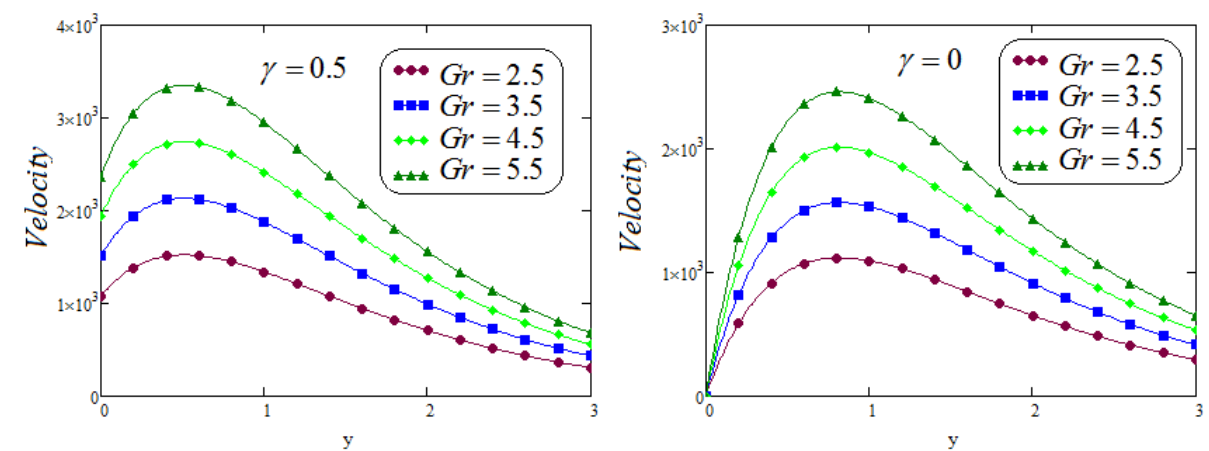
Figure 4. Velocity for varied values of G r with and without slip effect γ when f ( t ) = e at , a = 0.25, t = 1.5, α = 0.5, β = 0.3, P r = 0.71, λ 1 = 0.6, λ 2 = 0.2, M = 2.